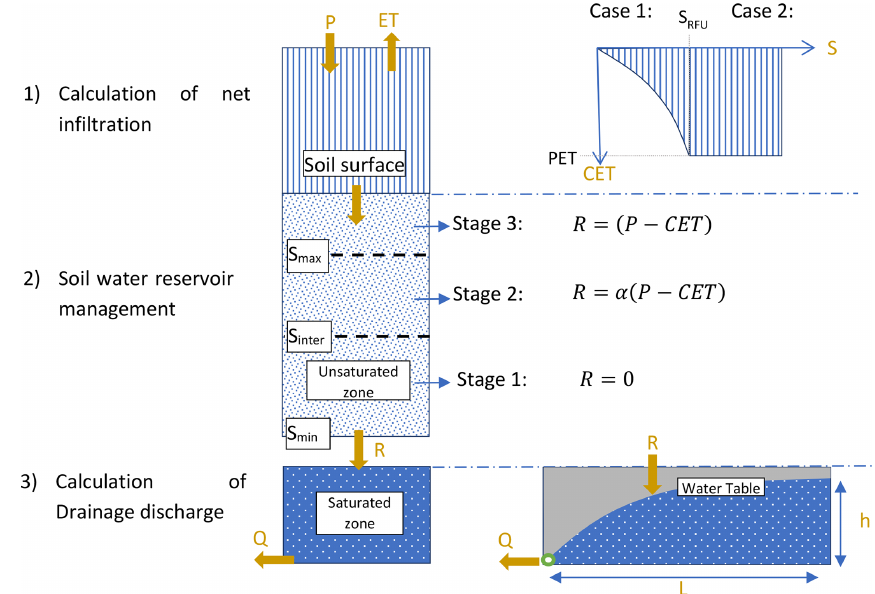
Figure 2. Diagram presenting the various modeling stages of the SIDRA-RU